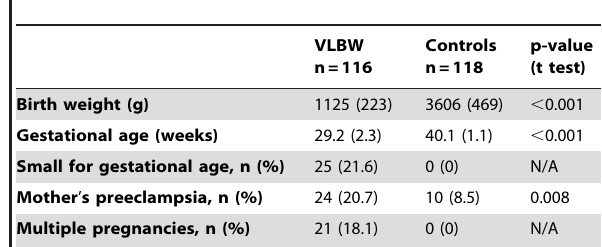
Table 1. Prenatal and birth characteristics of very low birth weight (VLBW, , 1500g) infants and term born controls; numbers represent mean (SD, standard deviation) or n